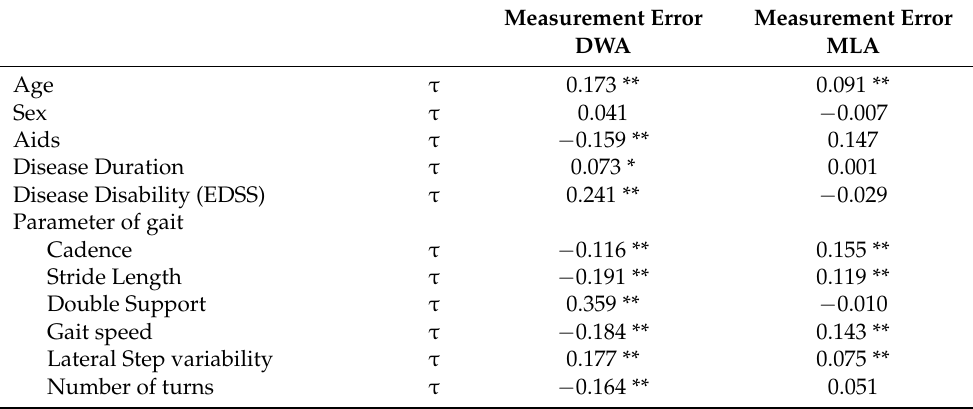
Table 3. Kendall ´ s tau-b correlation between demographic data, clinical outcomes, and parameter of gait (n = 562); EDSS = Expanded Disability Status Scale; DWA = Digiwalk algorithm; MLA= Mobility Lab algorithm. Measurement Error Measurement Error DWA MLA Age τ 0.173 ** 0.091 ** Sex τ 0.041 − 0.007 Aids τ − 0.159 ** 0.147 Disease Duration τ 0.073 * 0.001 Disease Disability (EDSS) τ 0.241 ** − 0.029 Parameter of gait Cadence τ − 0.116 ** 0.155 ** Stride Length τ − 0.191 ** 0.119 ** Double Support τ 0.359 ** − 0.010 Gait speed τ − 0.184 ** 0.143 ** Lateral Step variability τ 0.177 ** 0.075 ** Number of turns τ